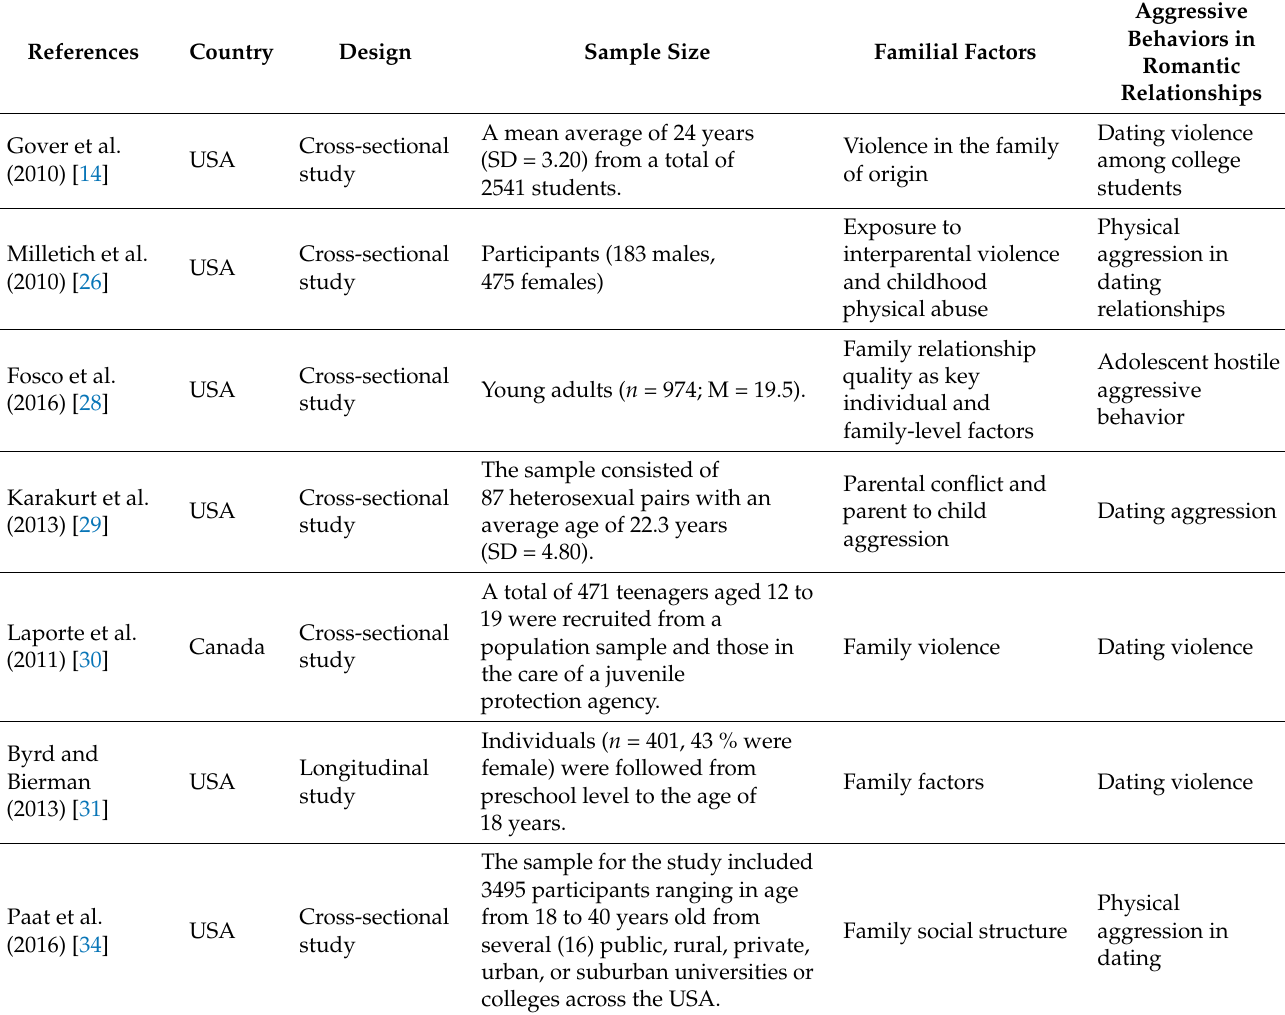
Table 3. General Description of